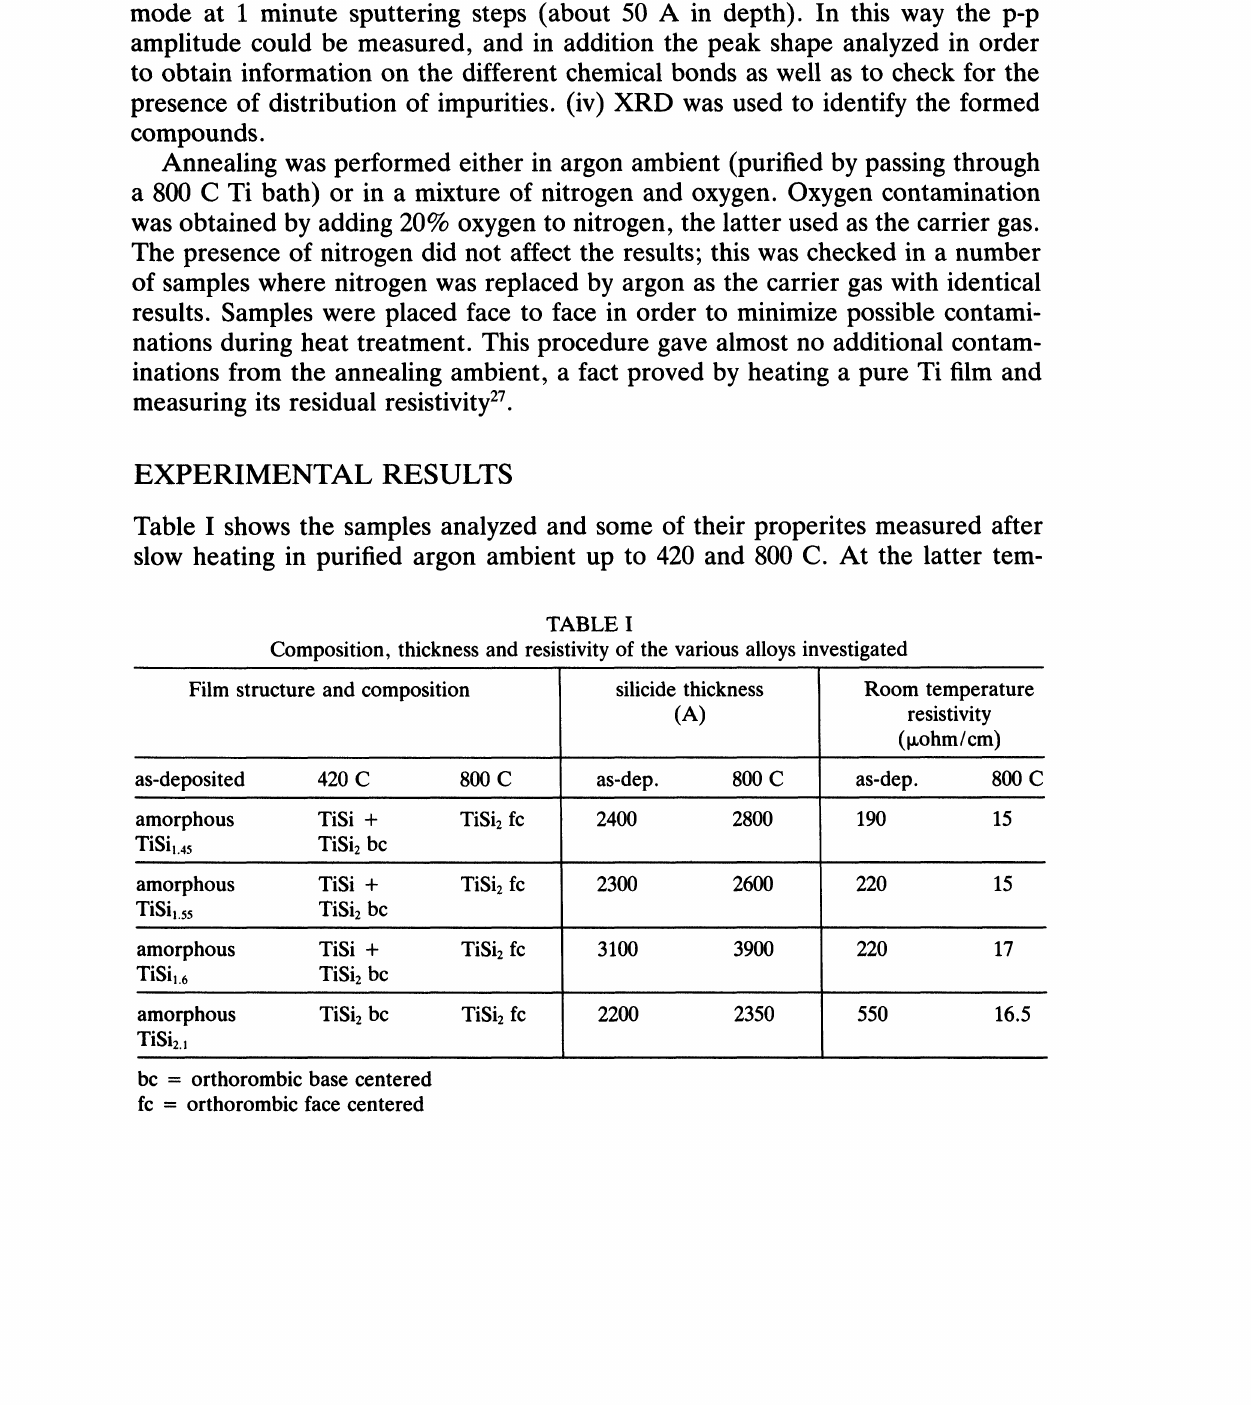
Composition, thickness and resistivity of the various alloys investigated Film structure and